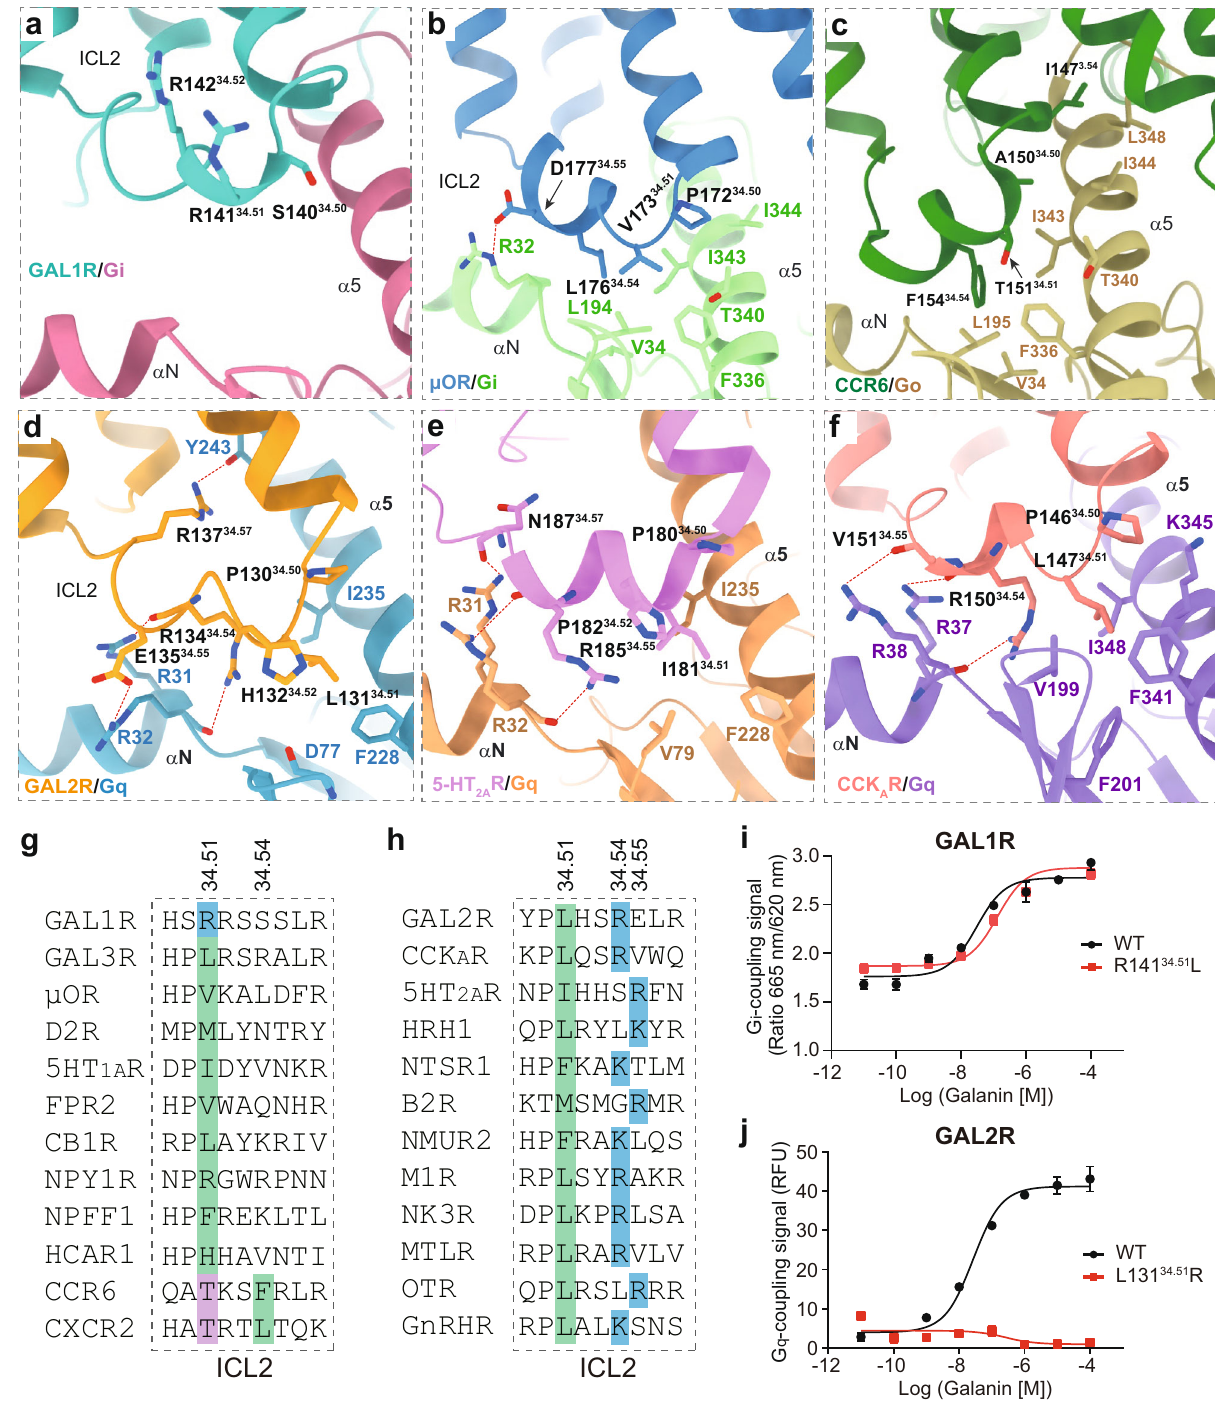
Fig. 6 Characteristics of ICL2 in G protein coupling of GAL1R and GAL2R. Detailed interaction between ICL2 of GAL1R ( a ), μ OR ( b ), and CCR6 ( c ) and the G α i subunit. Detailed interaction between ICL2 of GAL2R ( d ), 5-HT 2A R ( e ), and CCK A R ( f ) and the G α q subunit. g Sequence alignment of ICL2 of GAL1R and other class A GPCRs primarily coupled to G i heterotrimer. The positive-charged arginine in ICL2 of GAL1R (blue) and polar residue threonine in ICL2 of CCR6 and CXCR2 (purple) at 34.51 are highlighted. Hydrophobic residues at 34.54 in CCR6 and CXCR2, which substantially contribute to the receptor-G i coupling, are indicated in green. The conserved hydrophobic residues in other listed class A GPCRs at 34.51 are highlighted in green. h Sequence alignment of ICL2 of GAL1R and other class A GPCRs primarily coupled to G q heterotrimer. The conserved hydrophobic residues at 34.51 are highlighted in green. The positively charged residues at 34.54 and 34.55 are indicated in blue. The swapping effects of R141 34.51 of GAL1R ( i ) and L131 34.51 of GAL2R ( j ) on G protein-coupling activity. Data shown are mean ± S.E.M. of three ( n = 3, i ) or four ( n = 4, j ) independent experiments. Source data are provided as a Source Data fi